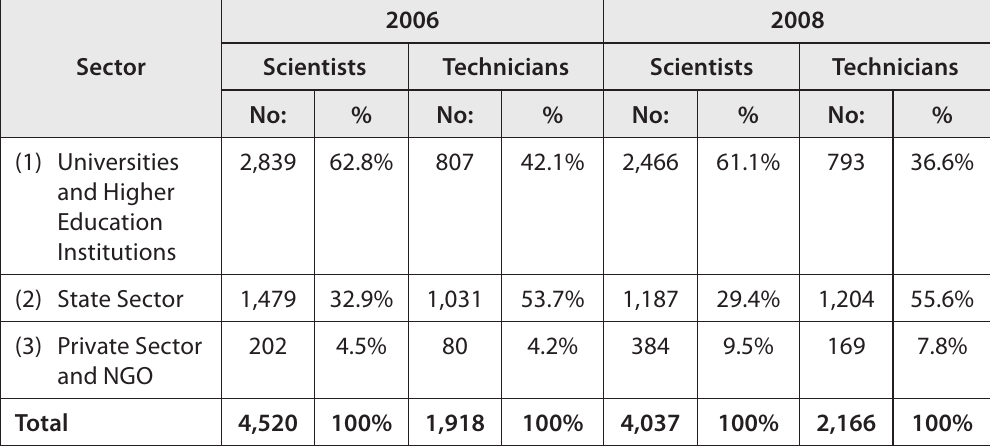
Table 3 Number of research and development scientists/technicians by sector in Sri Lanka Source: National R & D Surveys, Sri Lanka 2006 and 2008,